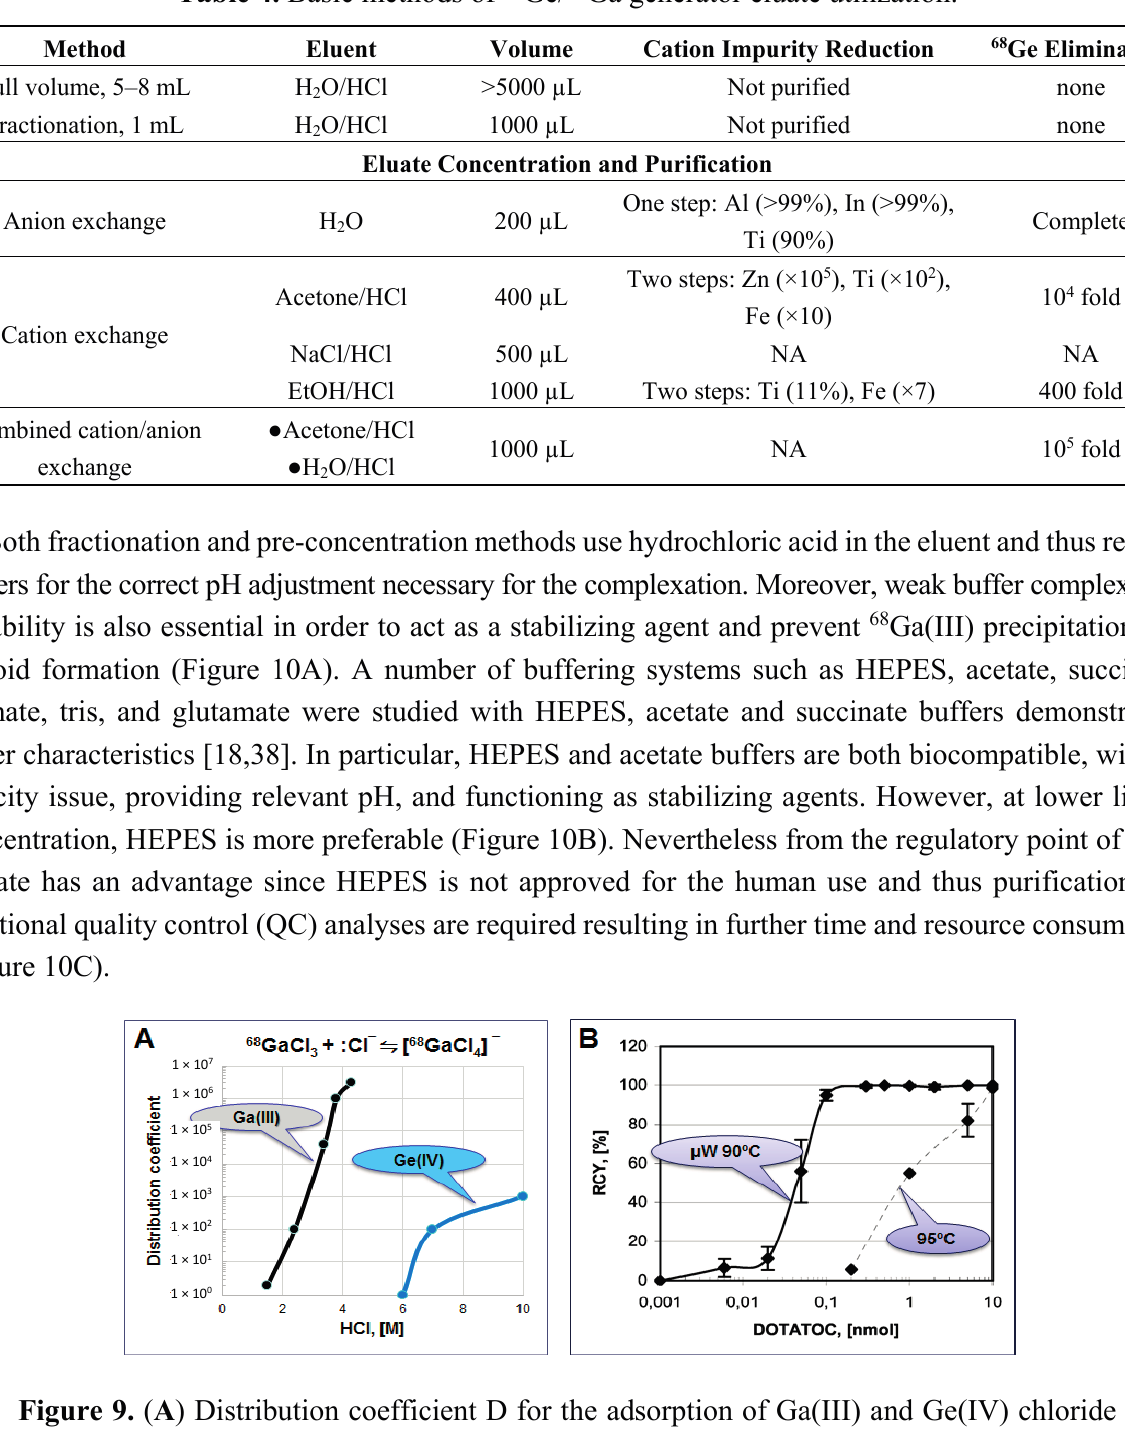
Figure 9. ( A ) Distribution coefficient D for the adsorption of Ga(III) and Ge(IV) chloride anions on an anion-exchange resin; ( B ) Influence of the DOTA-TOC amount on the decay-corrected radiochemical yield of the 68 Ga complexation reaction in HEPES buffer system using the full available 68 Ga radioactivity in 200 µL volume obtained after the pre-concentration and purification step. Solid line : 1 min microwave heating at 90 ± 5 °C, dashed line : 5 min conventional heating at 95